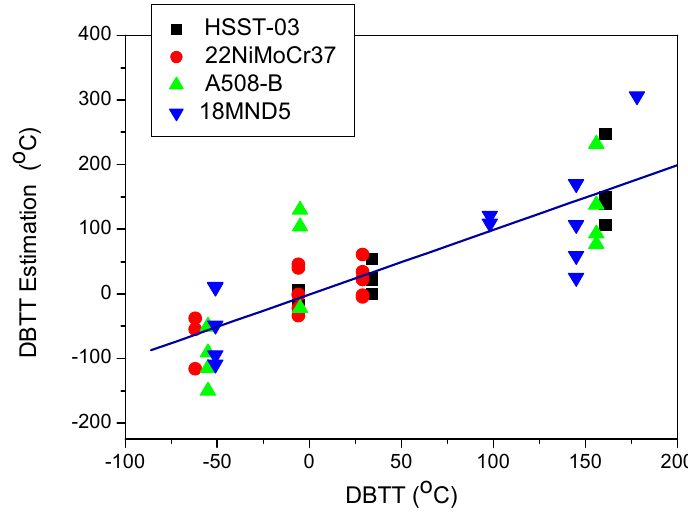
Figure 9. Estimated DBTT values as functions of measured DBTT values for all investigated